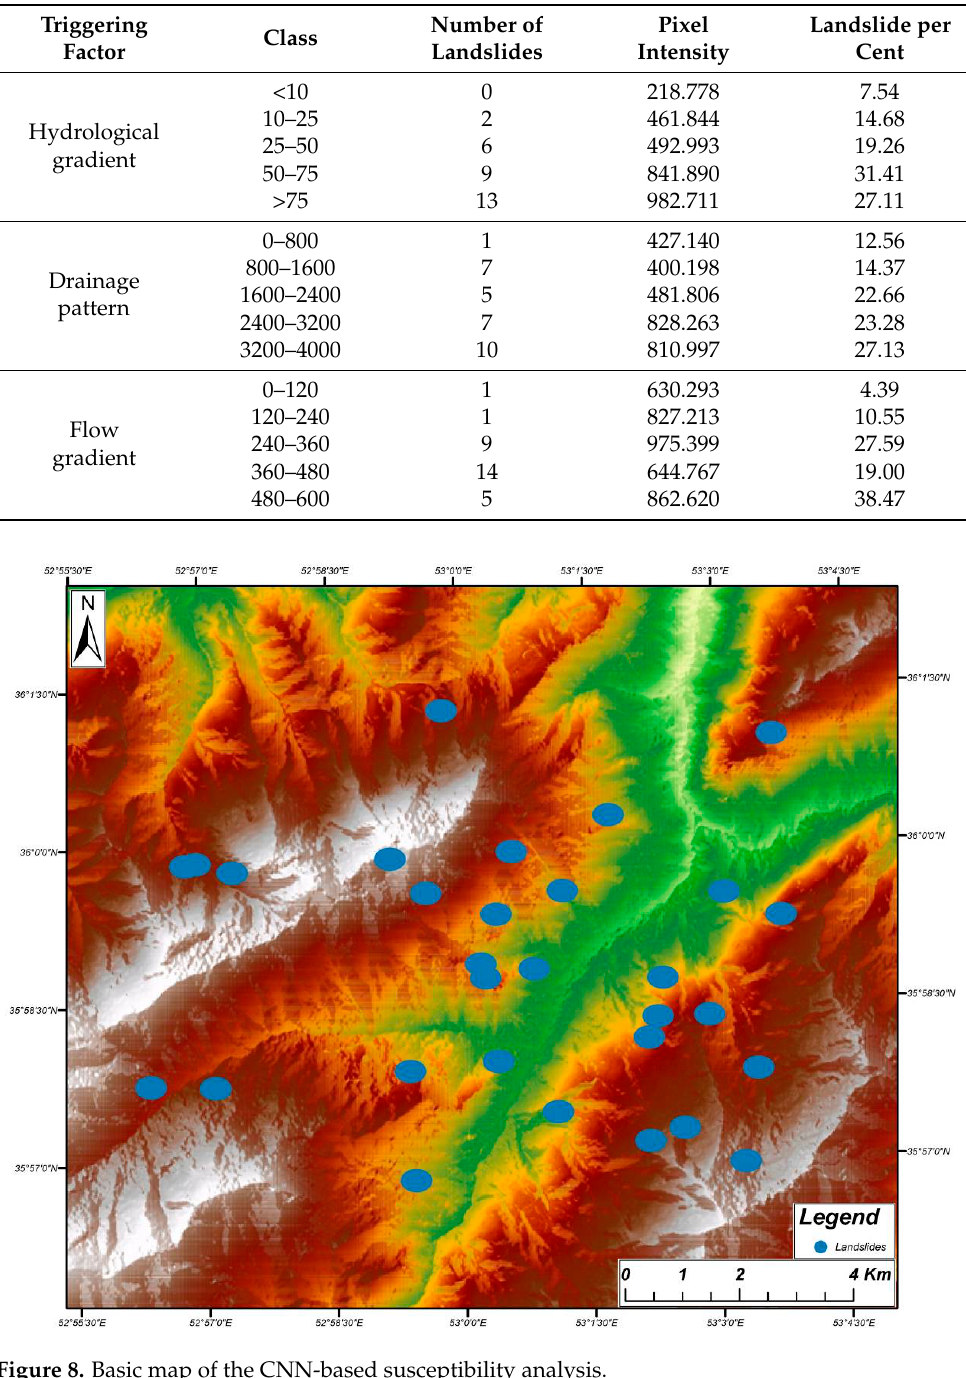
Figure 8. Basic map of the CNN-based susceptibility analysis.